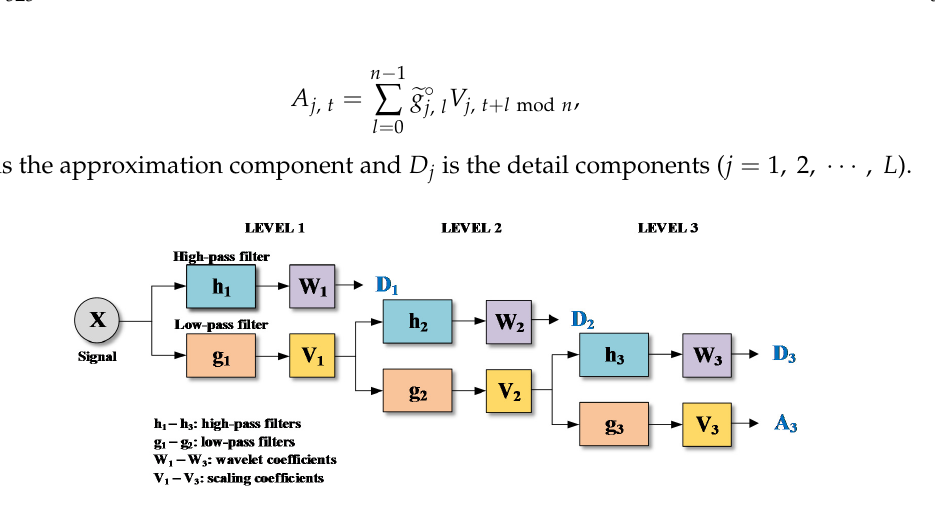
Figure 3. Flowchart for three-level MODWT.